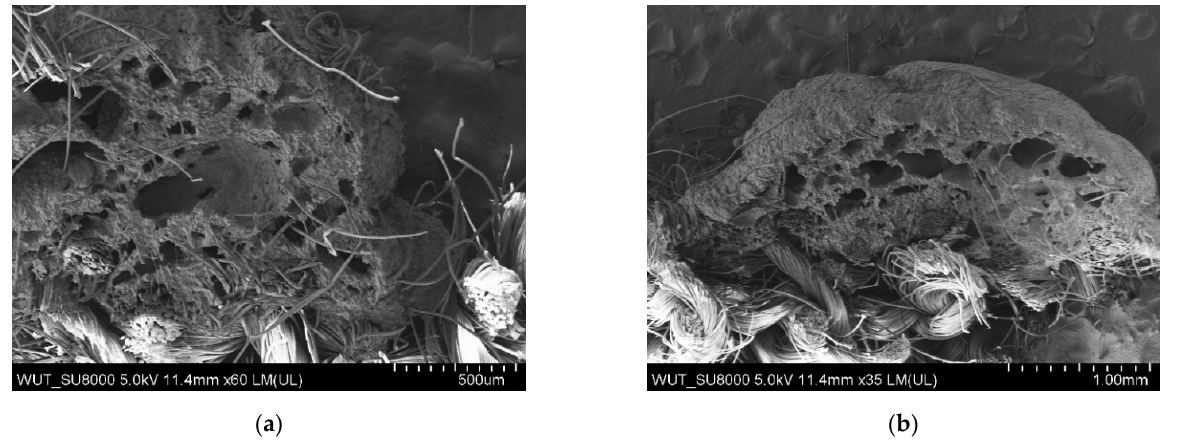
Figure 3. SEM images of the reference coating magnification ( a ) ×60 ( b ) ×35 .